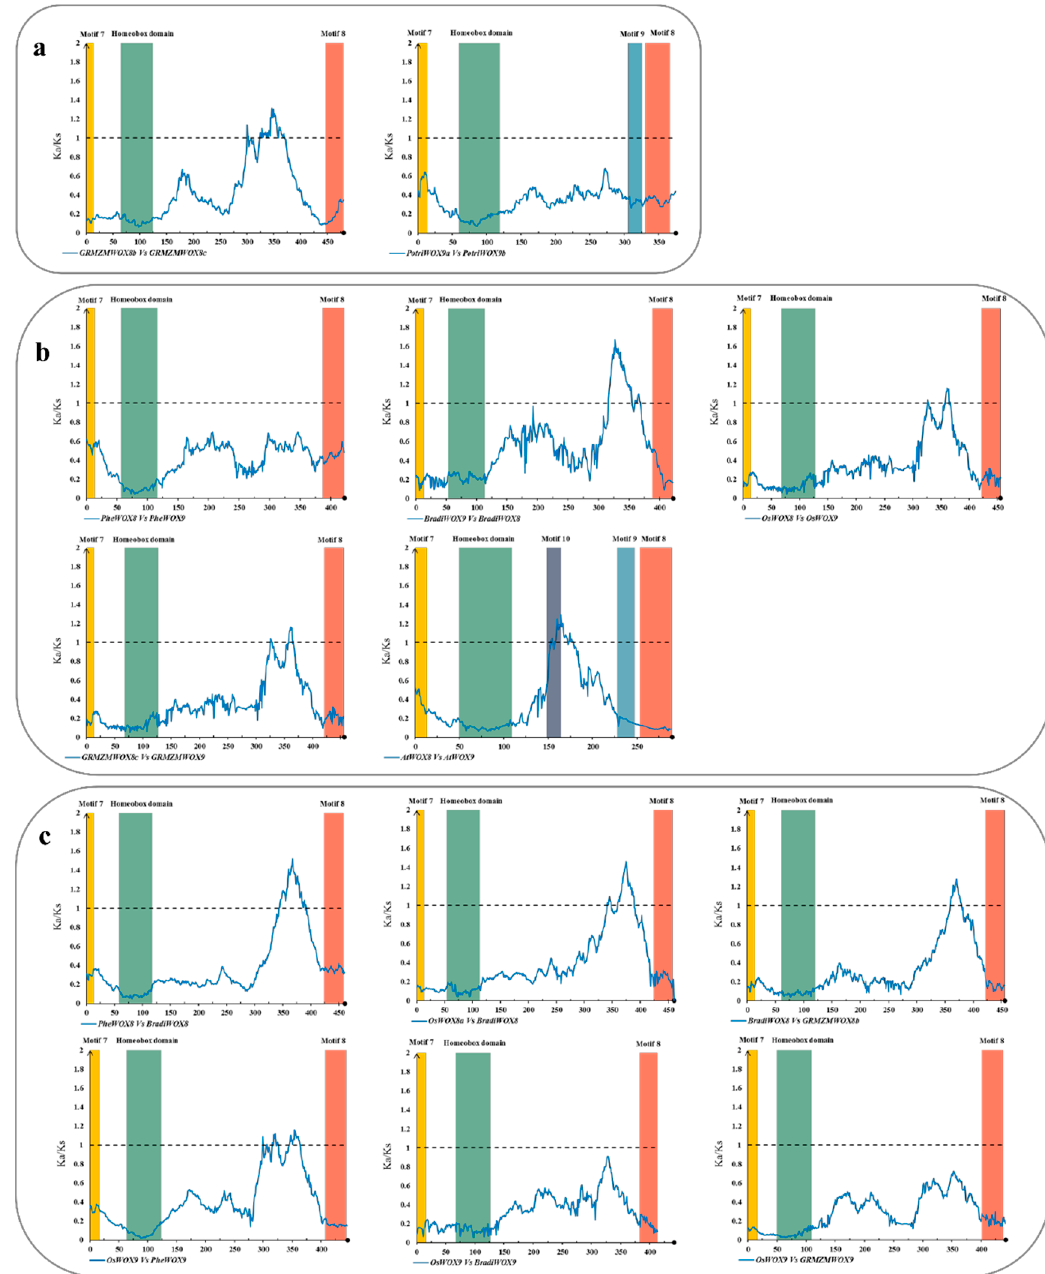
Figure 5. Sliding window of the WOX8 / 9 genes of the intermediate clade. ( a ) The sliding window of paralogous genes of WOX8 / 9 . ( b ) The sliding window of orthologous genes of WOX8s . ( c ) The sliding window of orthologous genes of WOX9s .